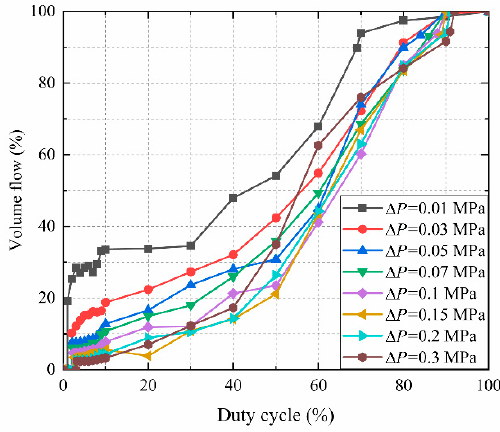
Figure 8. Normalized volume flow results from eight different pressure difference using a 100 Hz PWM frequency.